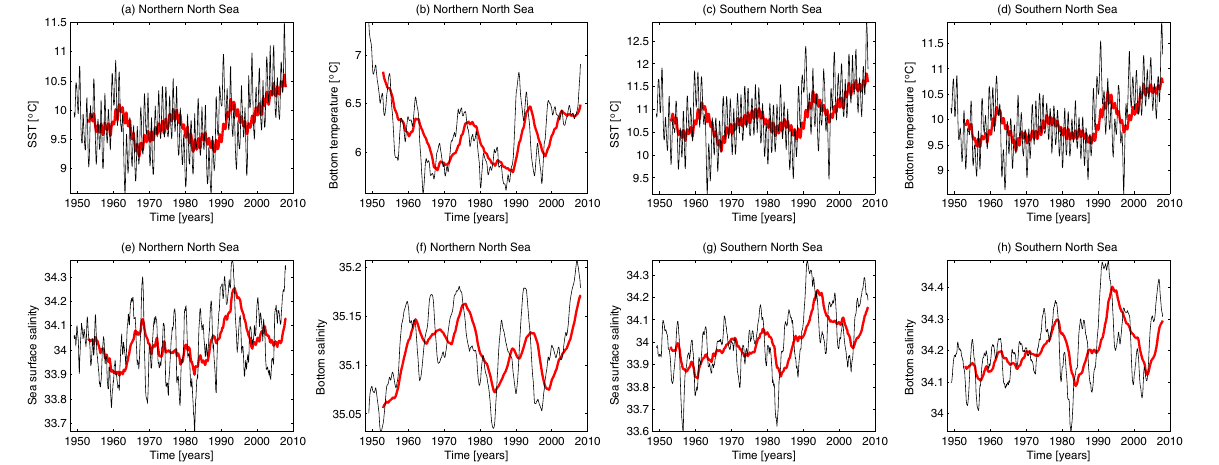
Figure 5. Northern North Sea (left two columns) and southern North Sea (right two columns) temperature (a, b, c, d) and salinity (e, f, g, h) in the surface (left) and bottom layers (right). Displayed are monthly data as a 13-point moving average (black) and 61-point moving average (red).